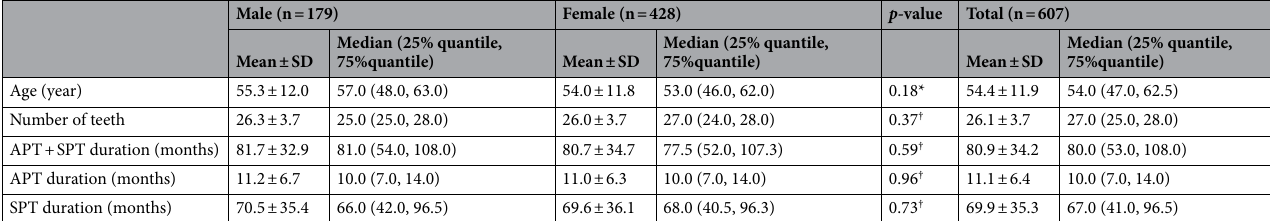
Table 1. Patient characteristics and treatment duration in total and by sex. Statistical analysis between the two groups with age was performed with Student’s t test. Statistical analysis between the two groups with other variables was performed with the Mann–Whitney U test. SD standard deviation; APT active periodontal therapy; SPT supportive periodontal therapy. * p- value from Student’s t test. † p- value from the Mann–Whitney U